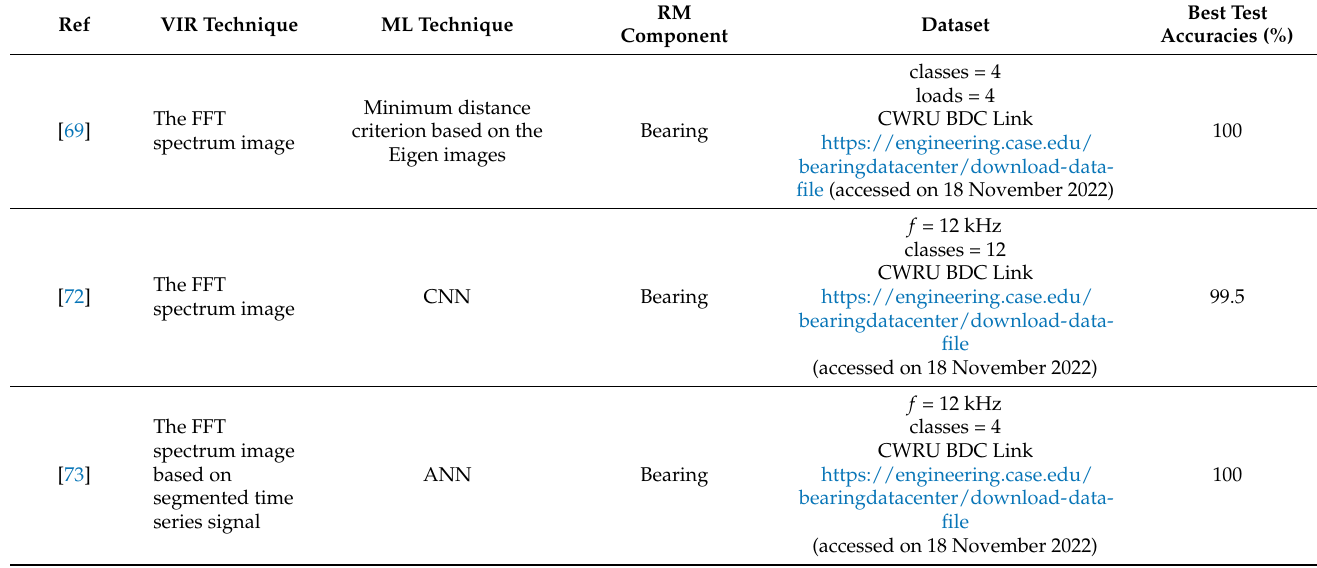
Table 2. Summary of the frequency domain vibration image representation techniques that are used in different studies of machine fault